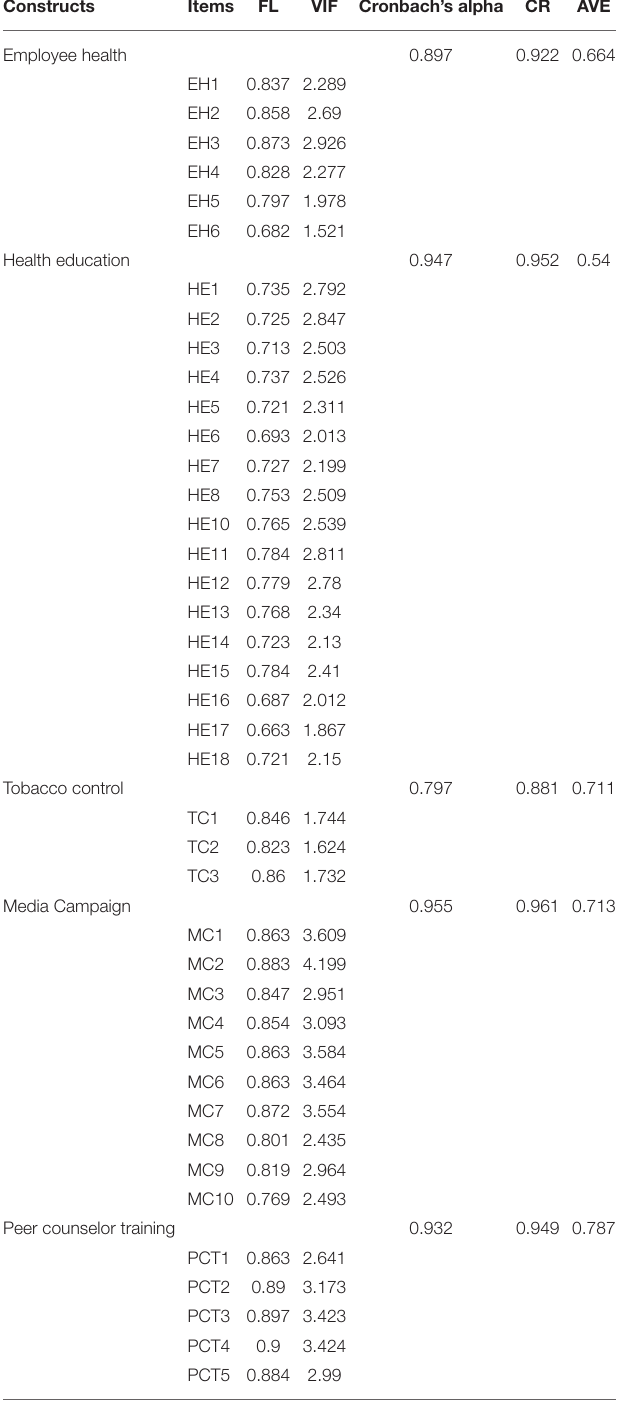
TABLE 3 | Factor loadings–Cronbach alpha, composite reliability, and AVE. Constructs